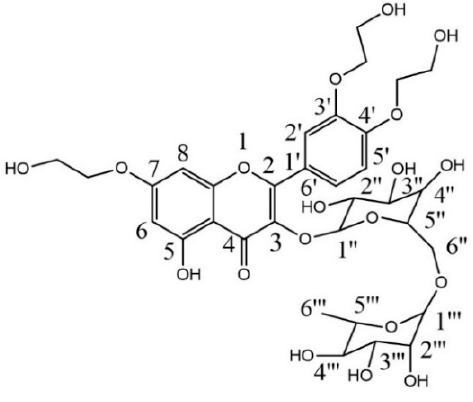
Figure 1. Chemical structure of troxerutin. Table 1. 1 H NMR and 13 C NMR data for troxerutin (DMSO-d 6 , δ ,